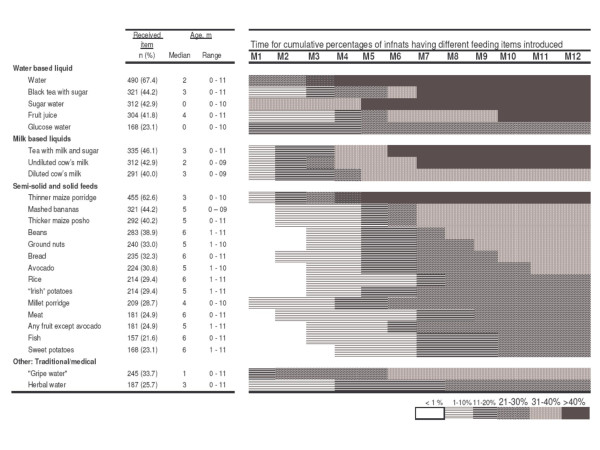
Introduction of the different food items for food items given to more than 20% of the infants, cumulative percentage. Median and range given.